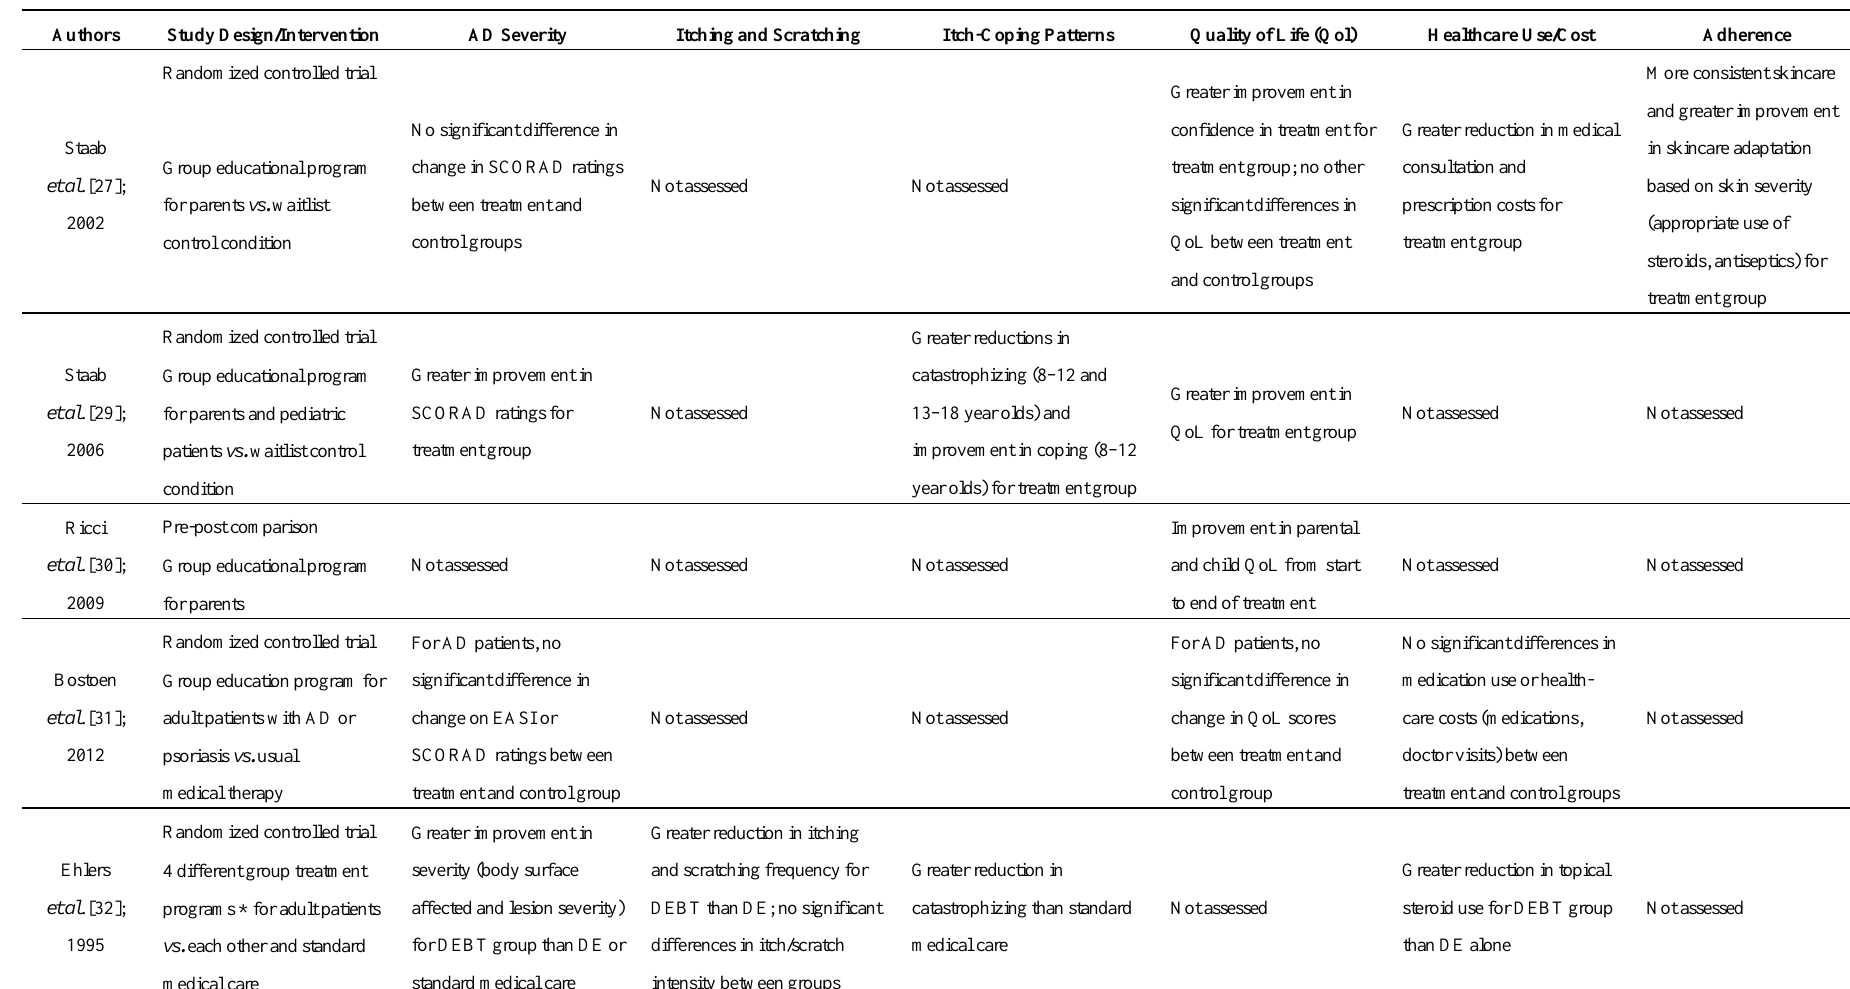
Table 1. Summary of outcomes for studies of multidisciplinary interventions for atopic